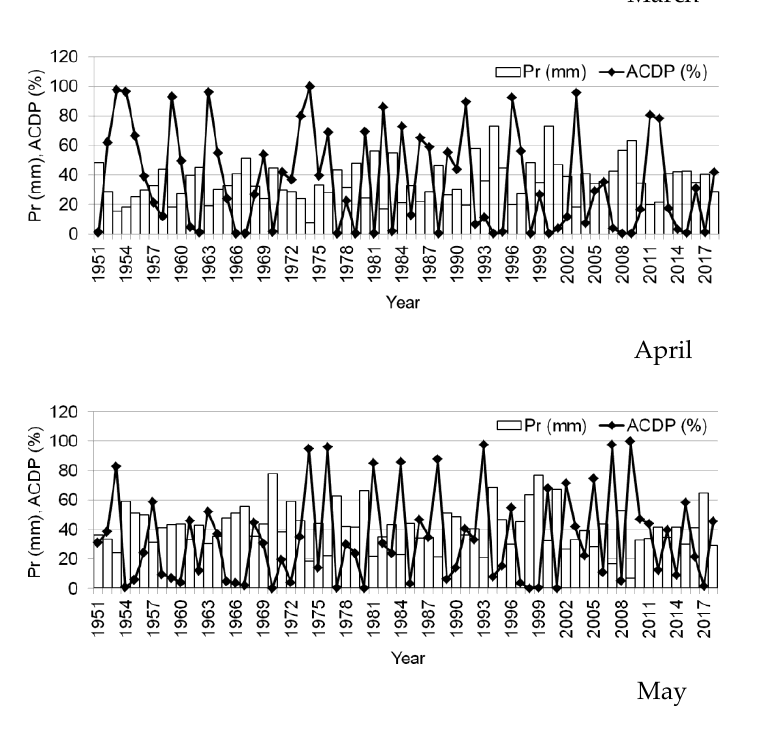
May Figure 9. Area of the country affected by deficient precipitation (ACDP) by months of different intensity: high ( ), medium ( ) and low ( ). Years 1951 – 2018. The highest values of ACDP, ≥90%, were in March for the years 1953, 1954, 1959, 1963, 1974, 1996 and 2003 (from 92.2 to 99.8%). In April the highest values of ACDP were